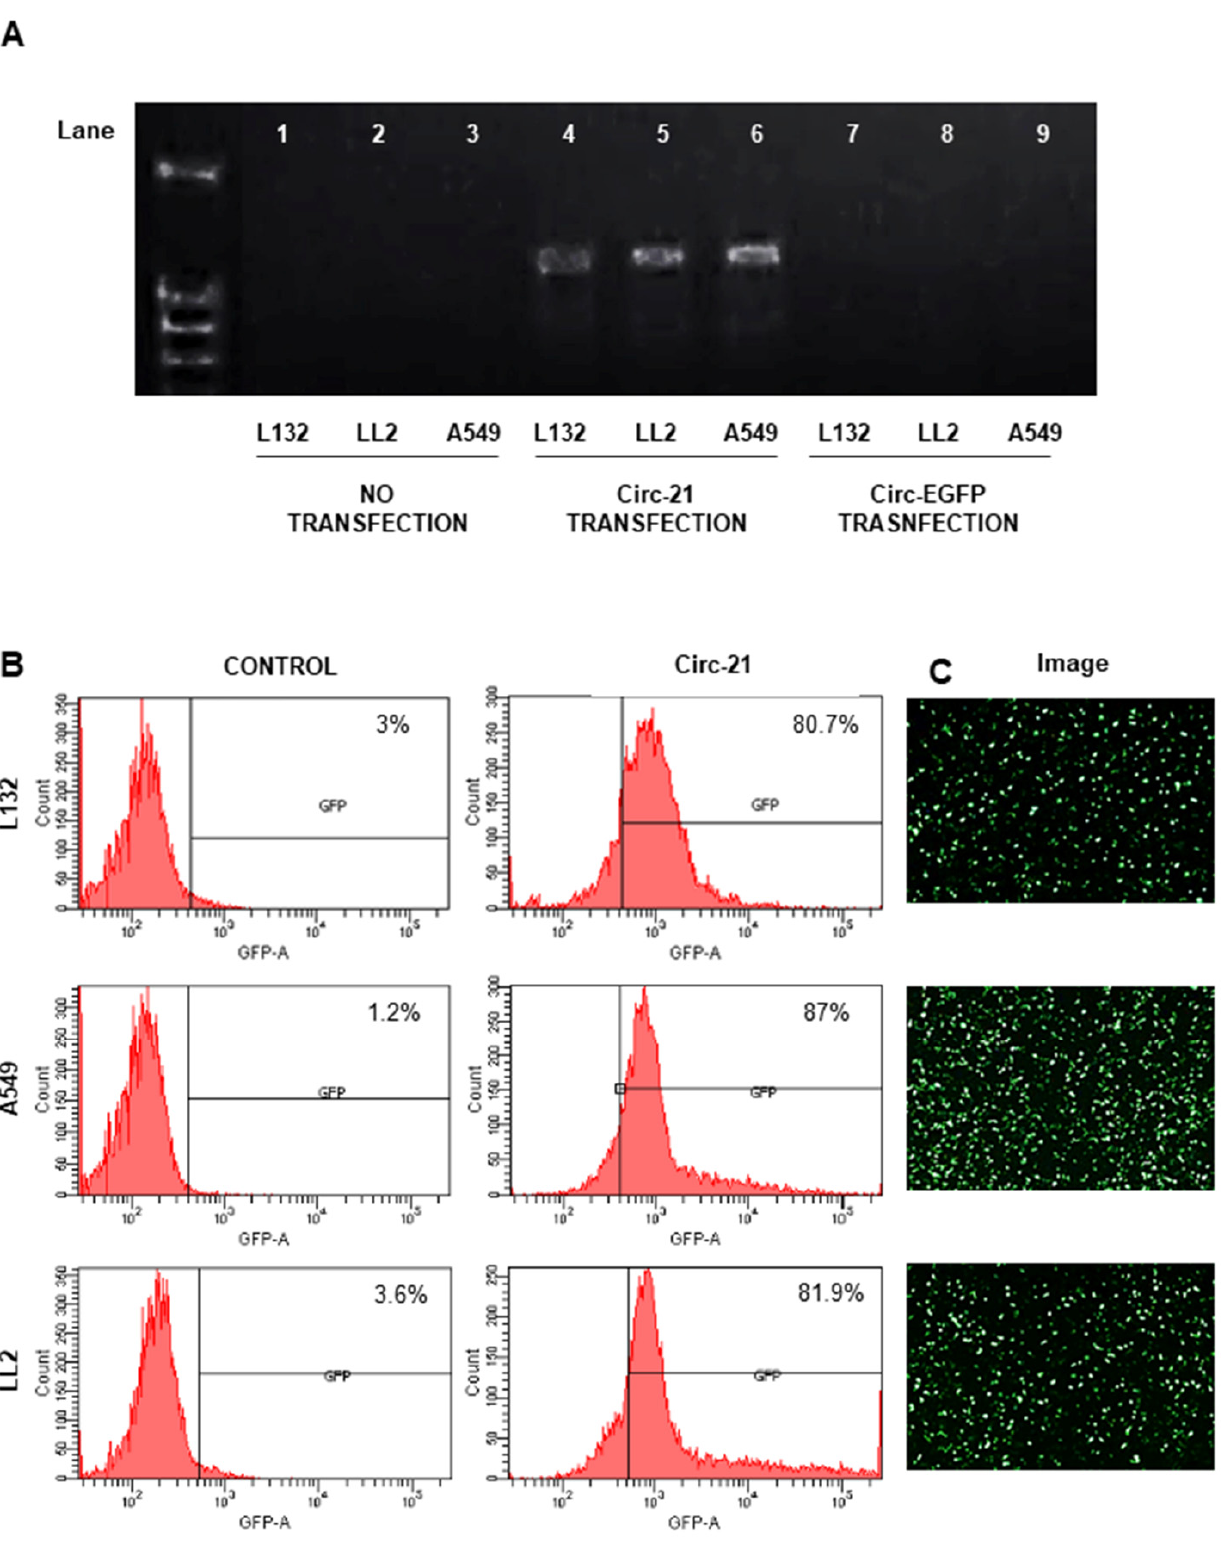
Figure 3. Detection of sponge miR-21 expression by PCR (32 cycles). ( A ) Lanes 1, 2 and 3, no trans- fected cells; Lanes 4, 5 and 6, cells transfected with Circ-21; and Lanes 7, 8 and 9, cells transfected with Circ-EGFP. ( B ) Flow cytometry analysis of EGFP expression. ( C ) EGFP fluorescence representative images (48 h after transfection) (4 ×